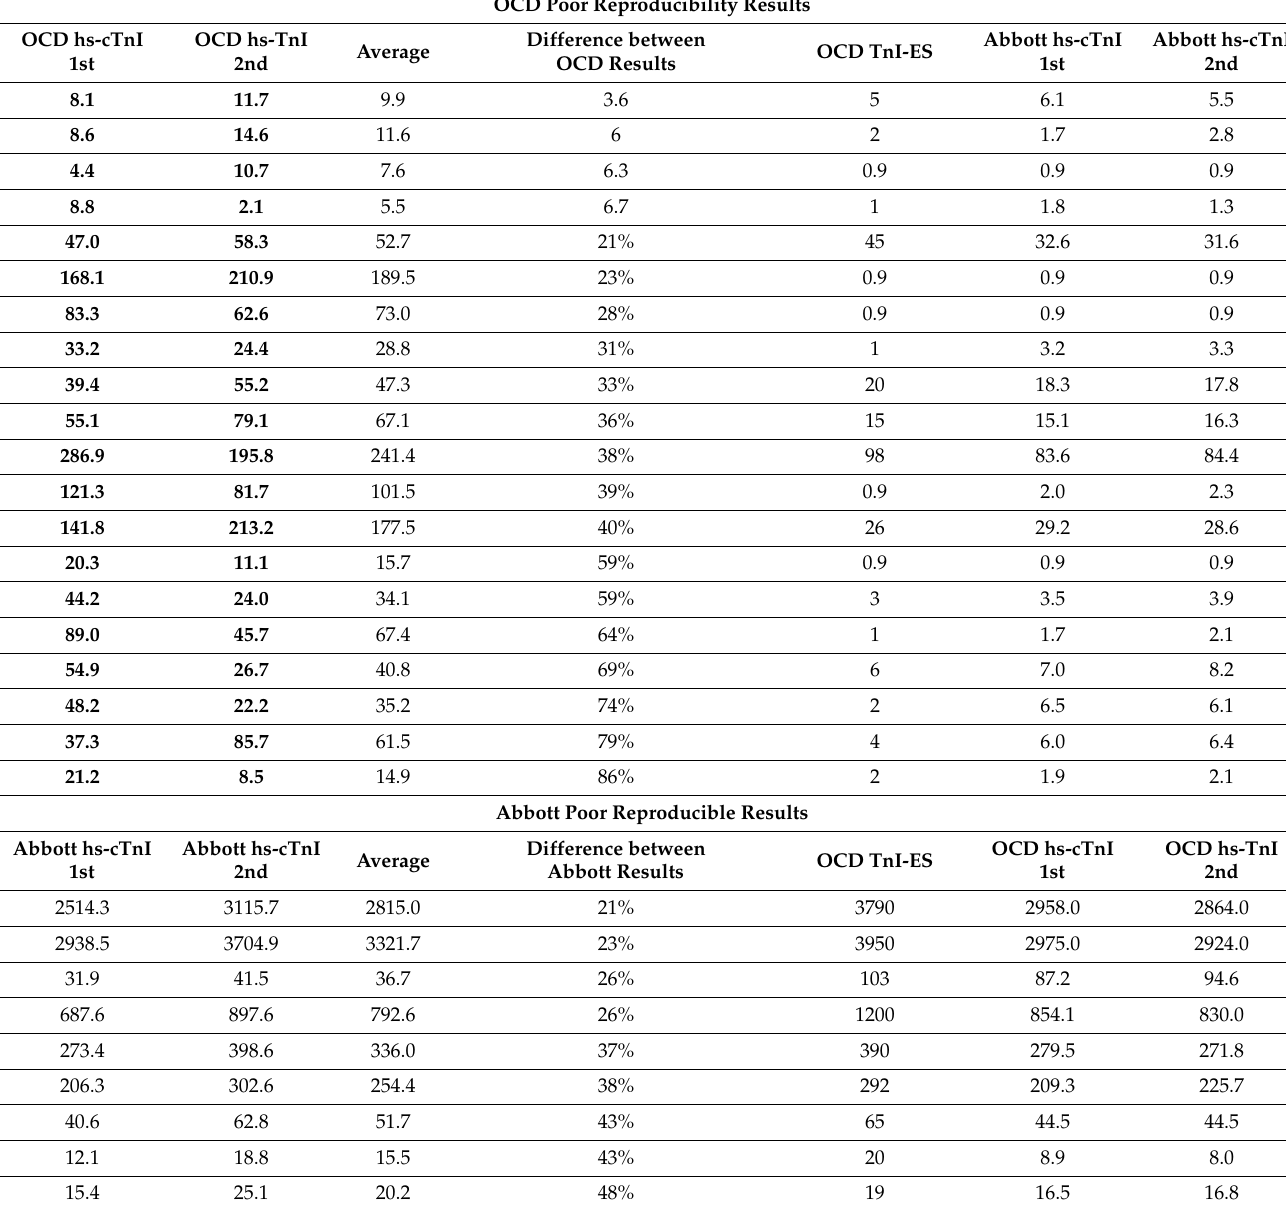
Table 1. Lithium heparin plasma samples that yielded poor reproducibility results (ng/L) for the OCD hs-cTnI assay and Abbott hs-cTnI assay. The bolded values indicate where both OCD hs-cTnI results are higher than the Abbott hs-cTnI results.